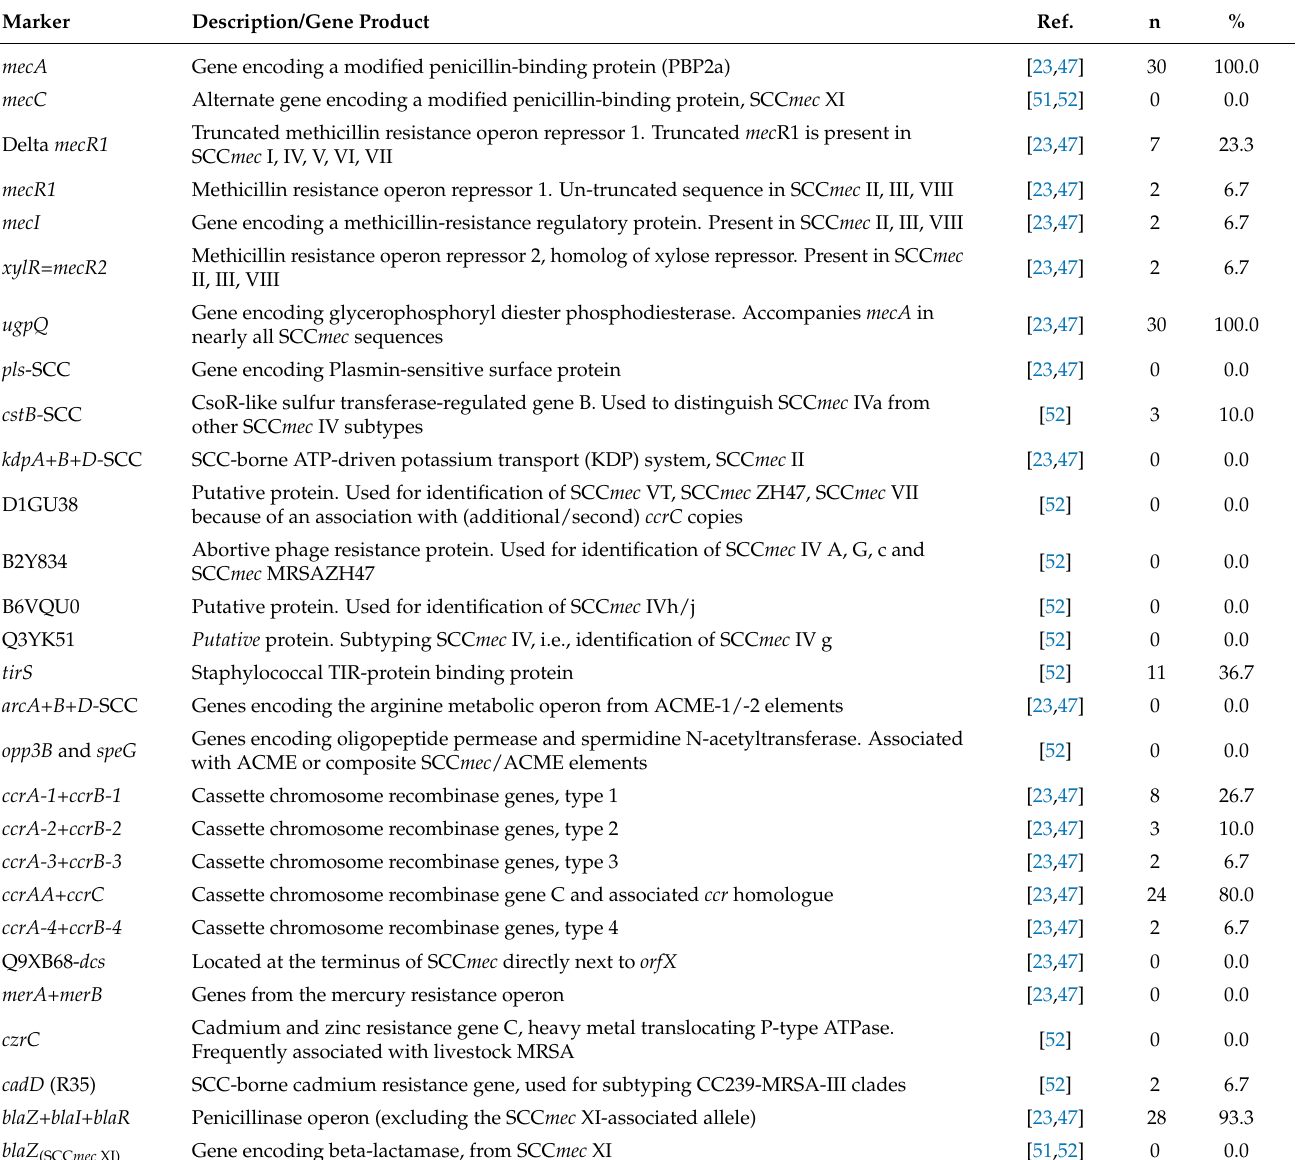
Table 3. Markers used for SCC mec subtyping and resistance